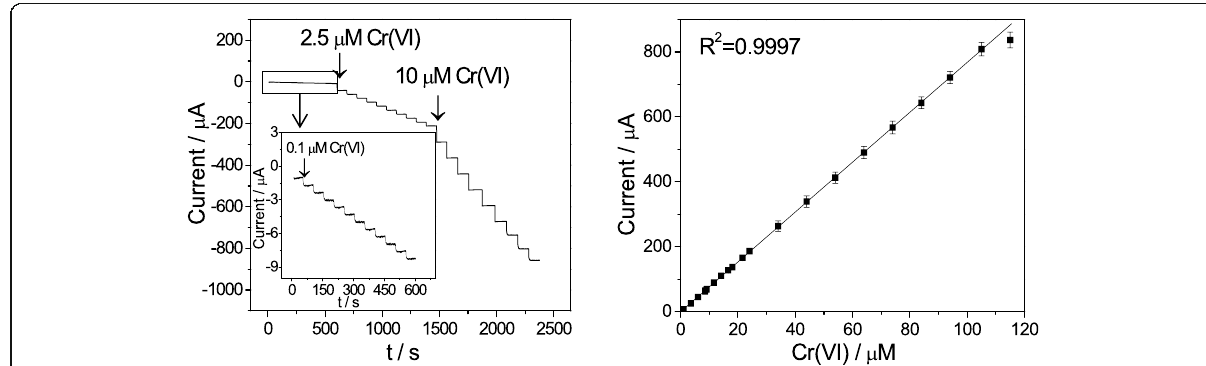
Fig. 9 (Left) Amperometric current responses of the successive addition of Cr(VI) in 0.1 M HCl solution. The inset is the enlarged part of low Cr(VI) concentration curve; (right) the calibration plot of the response against the Cr(VI) concentration (reprinted with permission from Reference Jin